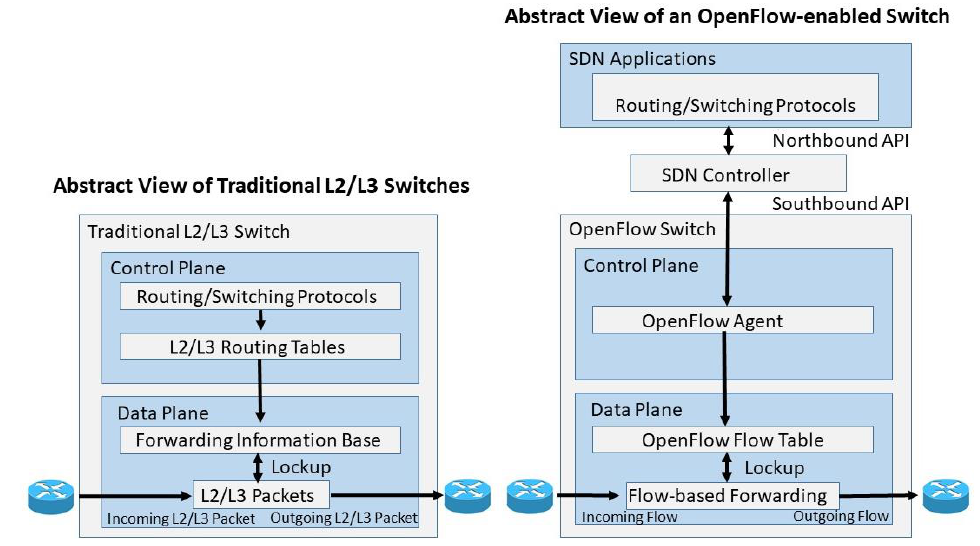
Figure 1. The differences between an SDN switch and a traditional switch [17,20,39].